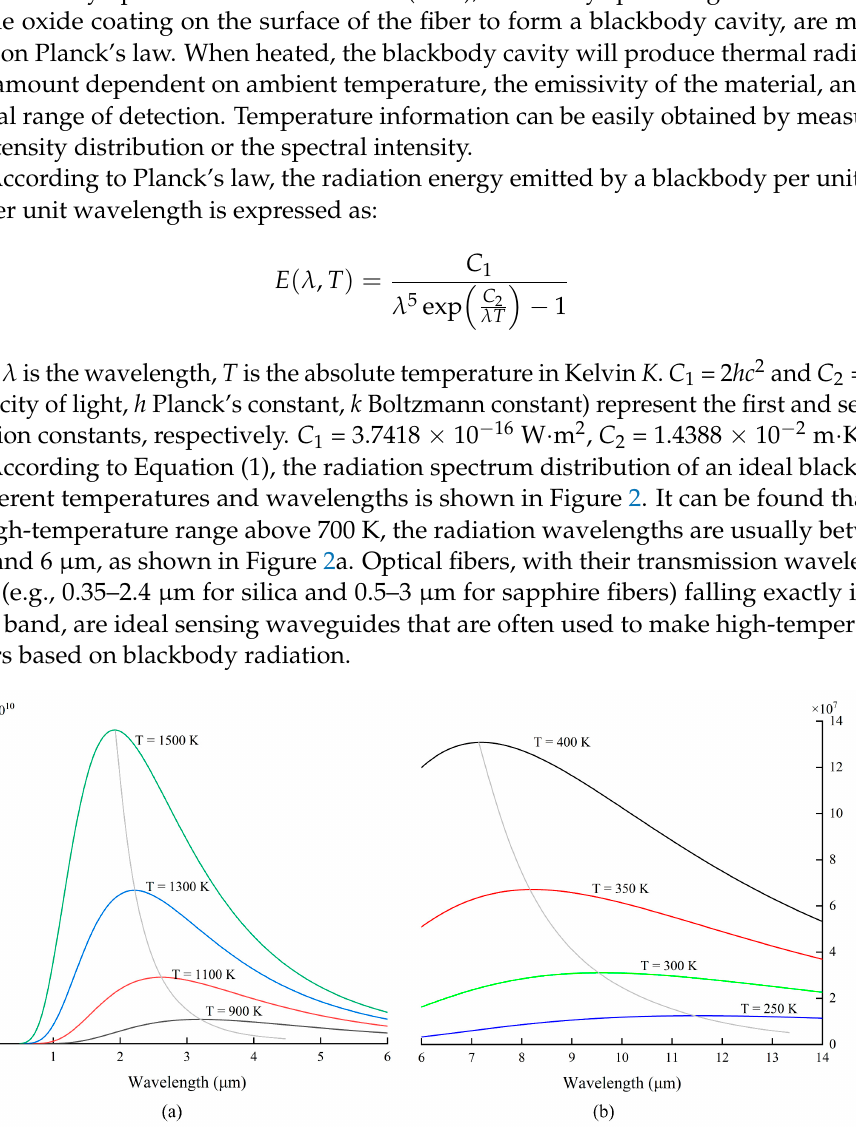
Figure 2. Planck’s law: electromagnetic radiation emitted by a blackbody in thermal equilibrium at a definite temperature. ( a ) High-temperature objects emit most of their radiation in the mid-wave infrared; ( b ) Low-temperature objects emit most of their radiation in the long-wave infrared. When thermal equilibrium is reached, the optical radiation of the blackbody OFT is an explicit function of the cavity temperature. Integration of the light intensity detected by the photodetector gives the total radiated power in the detection wavelength range λ 1 – λ 2 .